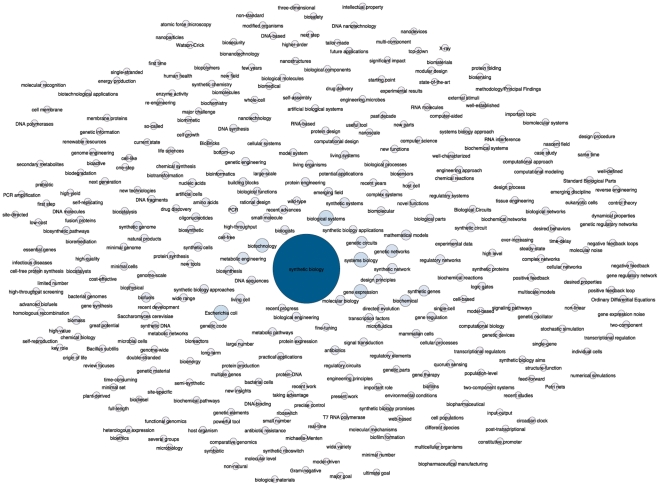
Key Terms Network.A Fruchterman-Reingold representation in Gephi of the top 356 aggregated terms of 36,262 terms within Web of Science literature for synthetic biology based on titles, abstracts and author keywords following stemming. Node size is based on the number of records. Node positions have been adjusted to clarify labels.